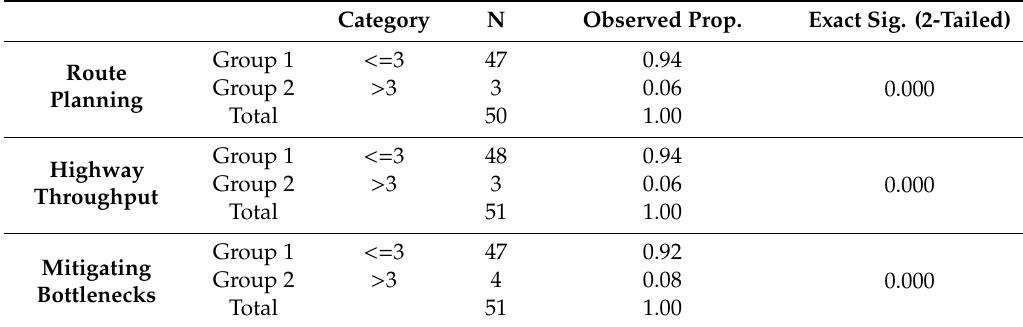
Table 4. Binomial test (Statistics) for Big Data.